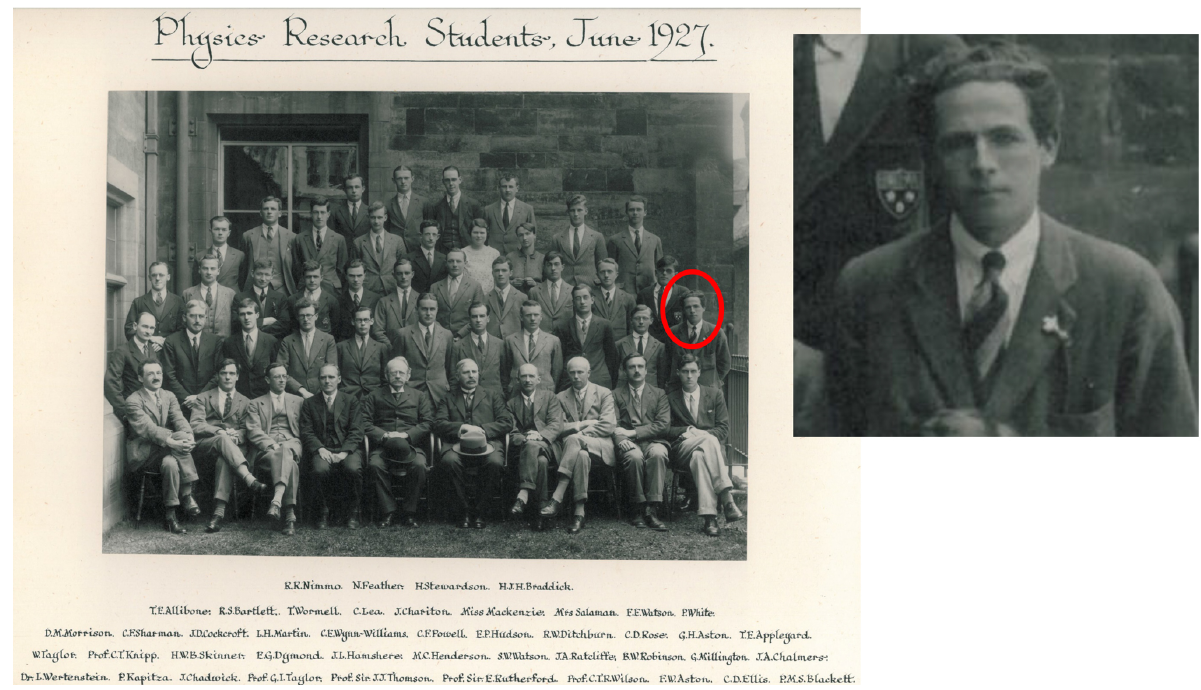
Figure 1. Staff and research students of the Cavendish Laboratory in 1927, with Chalmers inset. (Picture provided with the kind permission of Prof. M. Longair, Cavendish